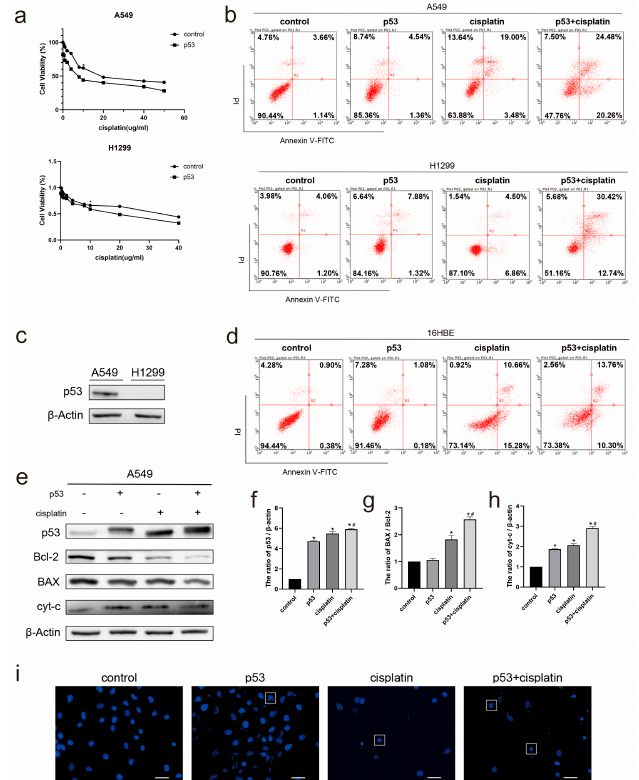
Figure 1. Combined treatment of p53 and cisplatin increased apoptosis in lung cancer cells. ( a ) Cell viability was determined by MTT assay. * p < 0.05 vs. control. ( b ) Cell apoptosis was assessed by staining with Annexin V − FITC and PI in A549 cells and H1299 cells transfected with p53 and/or treated with 10 μ M cisplatin for 24 h. ( c ) Western blot detection of p53 expression levels in A549 cells and H1299 cells. ( d ) Cell apoptosis was assessed by staining with Annexin V − FITC and PI in 16HBE cells transfected with p53 and/or treated with 10 μ M cisplatin for 24 h. ( e ) Western blot detection of apoptosis related proteins in A549 cells transfected with p53 and/or treated with 10 μ M cisplatin for 24 h. Quantitation of ( f ) p53, ( g ) cytochrome C levels, and ( h ) Bcl − 2/Bax ratio in A549 cells. Data are presented as mean ± SD, n = 3. * p < 0.05 vs. control and # p < 0.05 vs. cisplatin. ( i ) A549 cells transfected with p53 and/or treated with 10 μ M cisplatin for 24 h and stained with Hoechst 33342. Cell morphology was observed using confocal microscopy indicate apoptotic cells. Scale bar, 20 μ m.